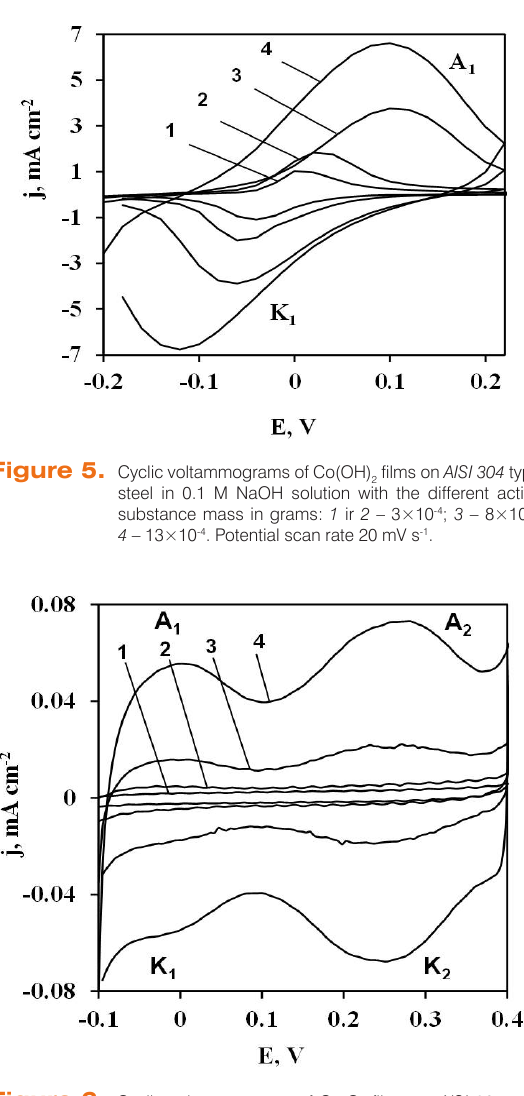
O films on AISI 304 type 3 4